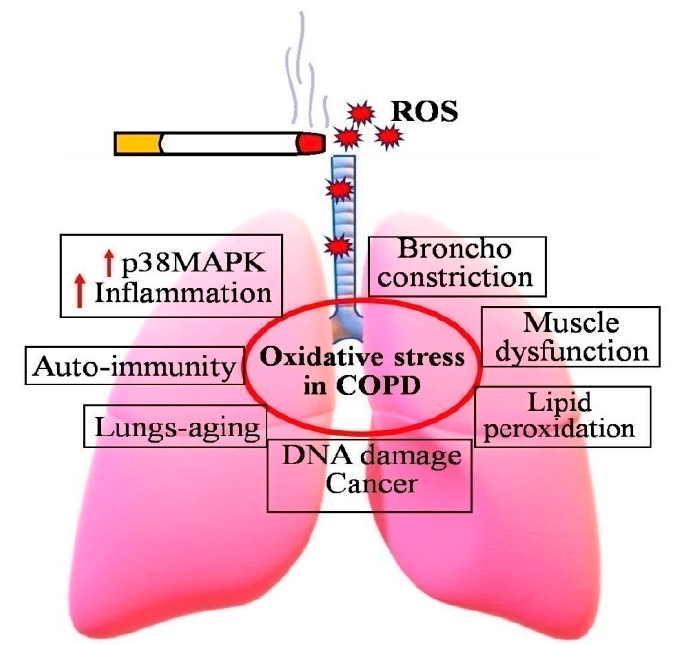
Figure 1. Consequences of increased oxidative stress in COPD patients. Cigarette smoking induces the formation of ROS, and thereby increases incidences of COPD and related diseases.